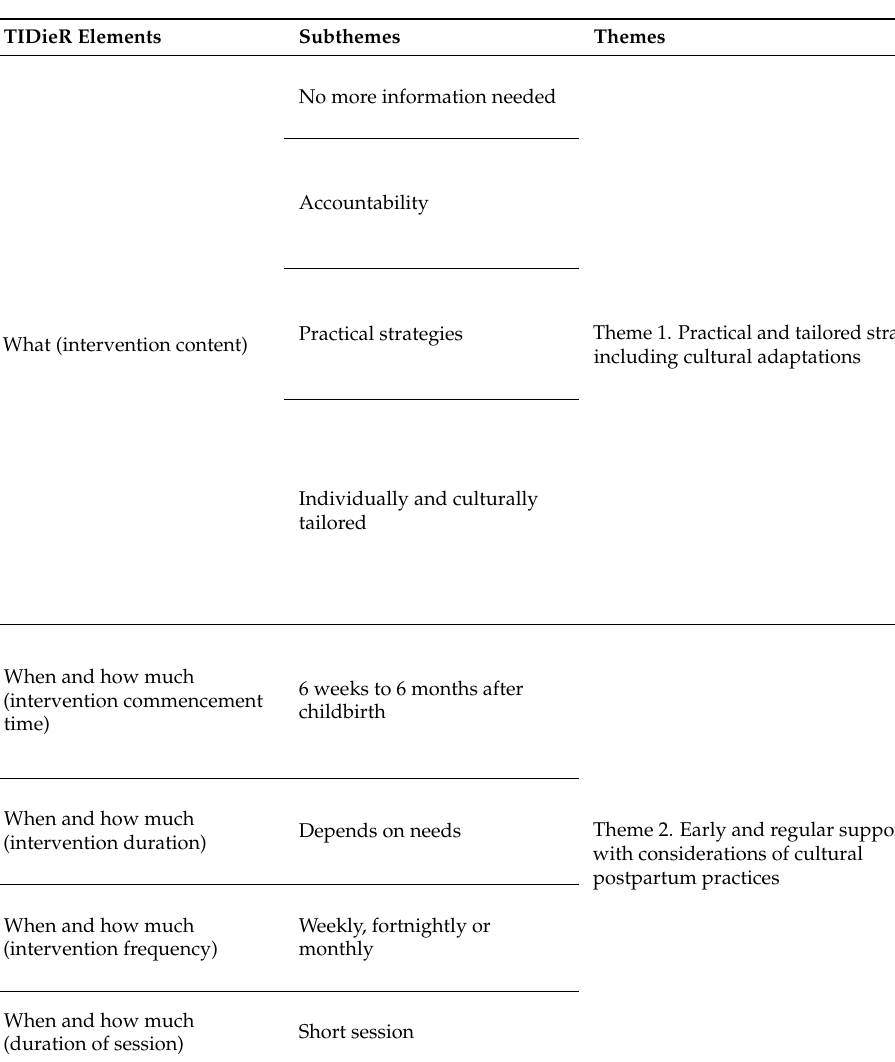
Table 3. Quotations from interview participants on the preferences for lifestyle intervention after childbirth according to TIDieR